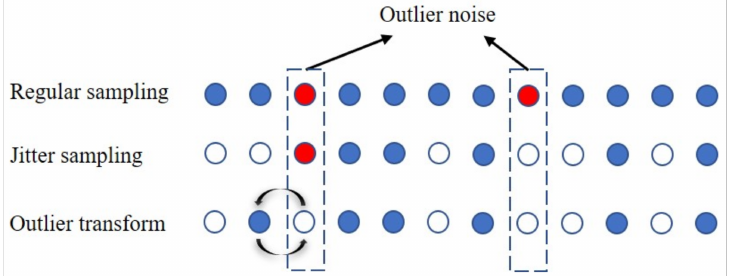
Figure 2. The outlier mask replacement strategy. The red dots represent outlier traces, the blue dots represent sampling traces, and the hollow dots represent unsampled